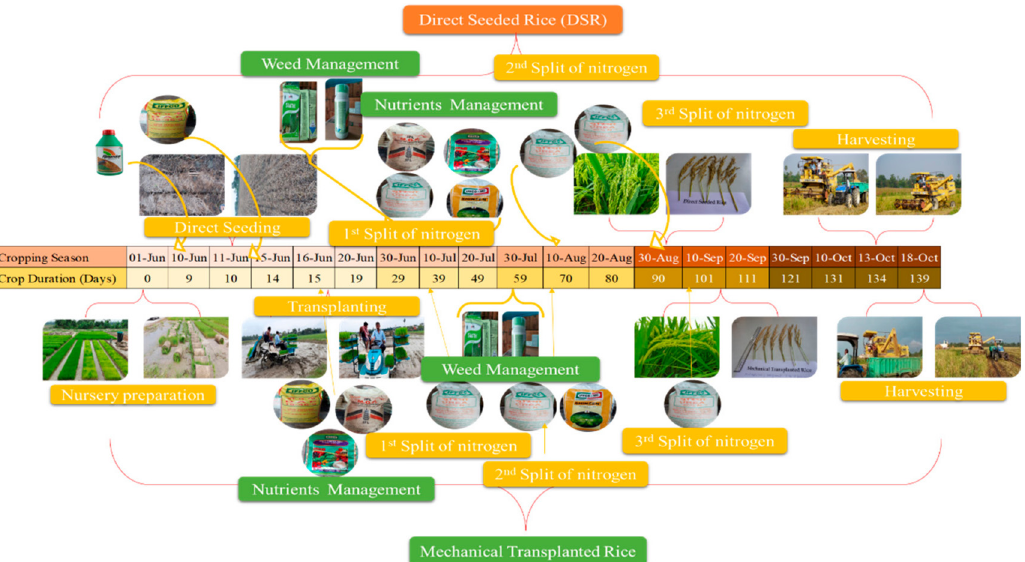
Figure 4. Different management practices under direct seeded and mechanically transplanted rice during the experiment (due to sufficient rains during the crop growth stages, no irrigation was provided to the